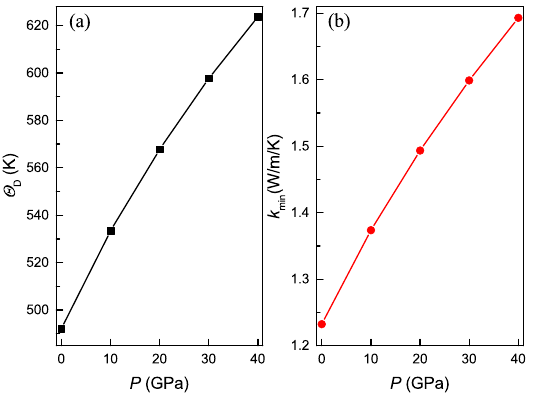
Figure 12. Polycrystal Debye temperature ( a ) and minimum thermal conductivity ( b ) as a function of pressure for the Ti 4 Nb 3 Al 9